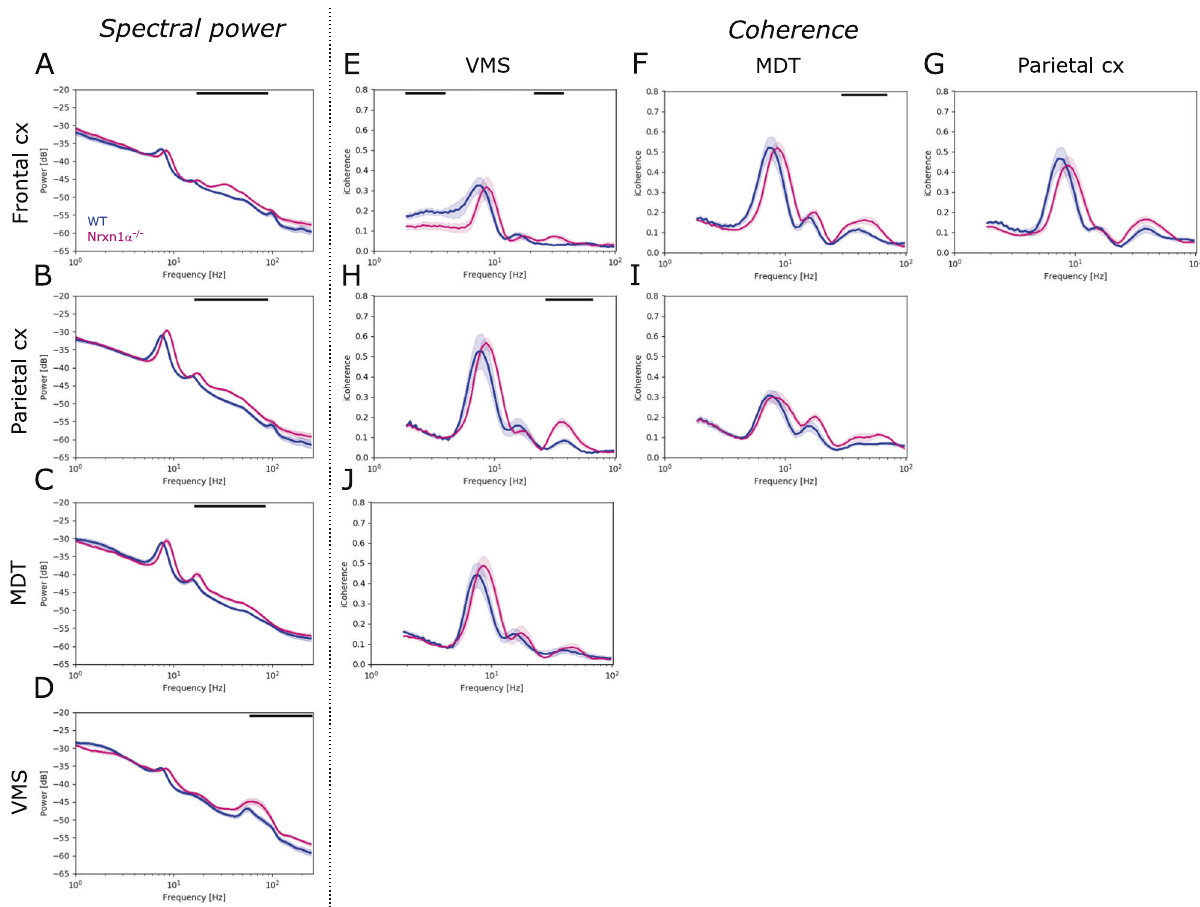
Fig. 2 Power and coherence of spontaneous brain oscillations. A – D Spectral power of spontaneous oscillations for each brain region (frontal cortex, parietal cortex, mediodorsal thalamus, MDT and ventromedial striatum, VMS) investigated. and E – J imaginary coherence between brain regions, e.g., E coherence between frontal cortex and VMS, F between frontal cortex and MDTor H between parietal cortex and VMS. WT ( N = 14) displayed in blue, Nrxn1 α − / − ( N = 14) shown in magenta. Data displayed as mean + SEM and tested with unpaired CBPT. Black bars above the graphs represent clusters with statistically signi fi cant